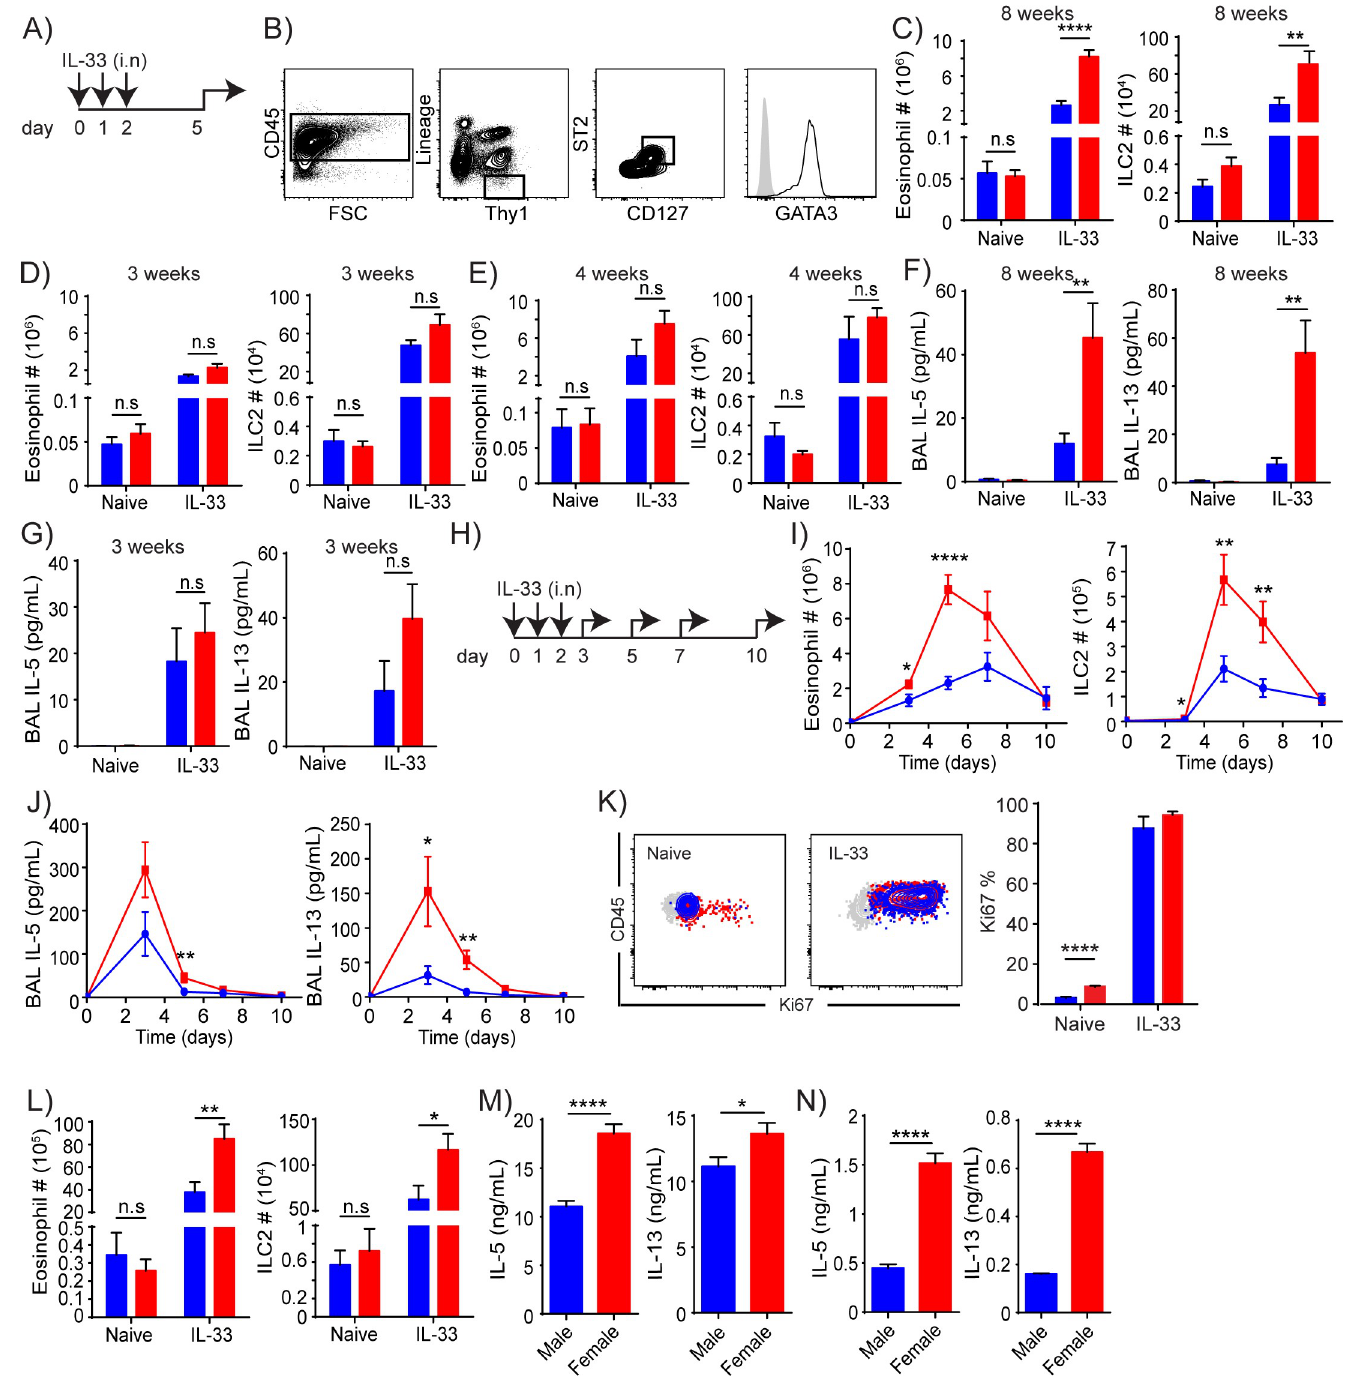
Fig 1. Female ILC2s respond more vigorously to IL-33 stimulation than male ILC2s. (A) Treatment scheme for in vivo experiments. (B) Gating strategy to identify ILC2s. They were identified as Lineage (CD3 ε , CD4, CD19, CD11b, CD11c, TCR β , TCR γδ , NK1.1, Gr1, Ter119) - CD45 + Thy1(CD90) + CD127 + ST2 + cells and confirmed for GATA3 expression. Grey = fluorescence-minus-one control, black line = ILC2. (C-E) Eosinophil and ILC2 numbers in untreated or IL-33 treated 8 week- (C), 3 week- (D) and 4 week- (E) old mice 3 days after 3 consecutive IL-33 injections. (F,G) BALF cytokines in untreated or IL-33 treated 8 week- (F) and 3 week- (G) old mice 3 days after 3 consecutive IL-33 injections. (H) Treatment scheme for in vivo time-course analyses. (I, J) Eosinophil and ILC2 numbers (I) and BALF cytokines (J) were quantified at day 0 (naive) and then 1 day (day 3), 3 days (day 5), 5 days (day 7) and 8 days (day 10) after 3 consecutive IL-33 injections. (K) Ki67 staining of male (blue) and female (red) ILC2s before and 1 day after IL-33 injections. Grey = Isotype control. (L) Eosinophil and ILC2 numbers in untreated or IL-33 treated 8 week-old Rag1 -/- mice 3 days after 3 consecutive IL-33 administrations. (M, N) Amounts of IL-5 and IL-13 in supernatant collected from male or female